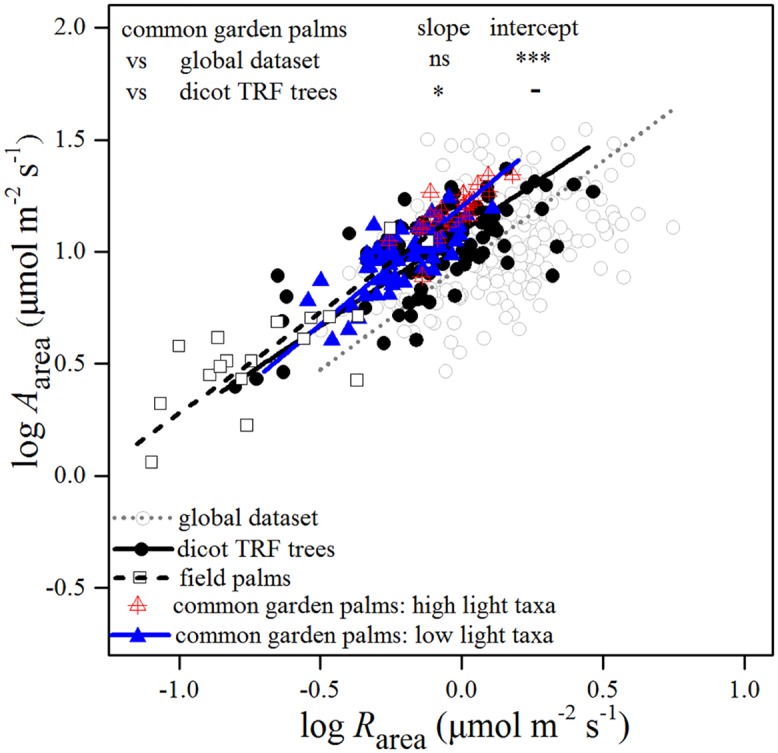
Relationships between area-based maximum photosynthetic rate (A
area) and dark respiration rate (R
area) across common garden palms, field palms, species from a global dataset and dicotyledonous broad-leaved trees in tropical rain forests (dicot TRF trees).Relationships in each dataset are significant and their standardized major axis (SMA) regression lines are shown. The differences in SMA regression slope and intercept between common garden palms and two other non-palm datasets are indicated (see S4 Table for the differences between field palms and two other non-palm datasets). ns, P > 0.05, *** P < 0.001.